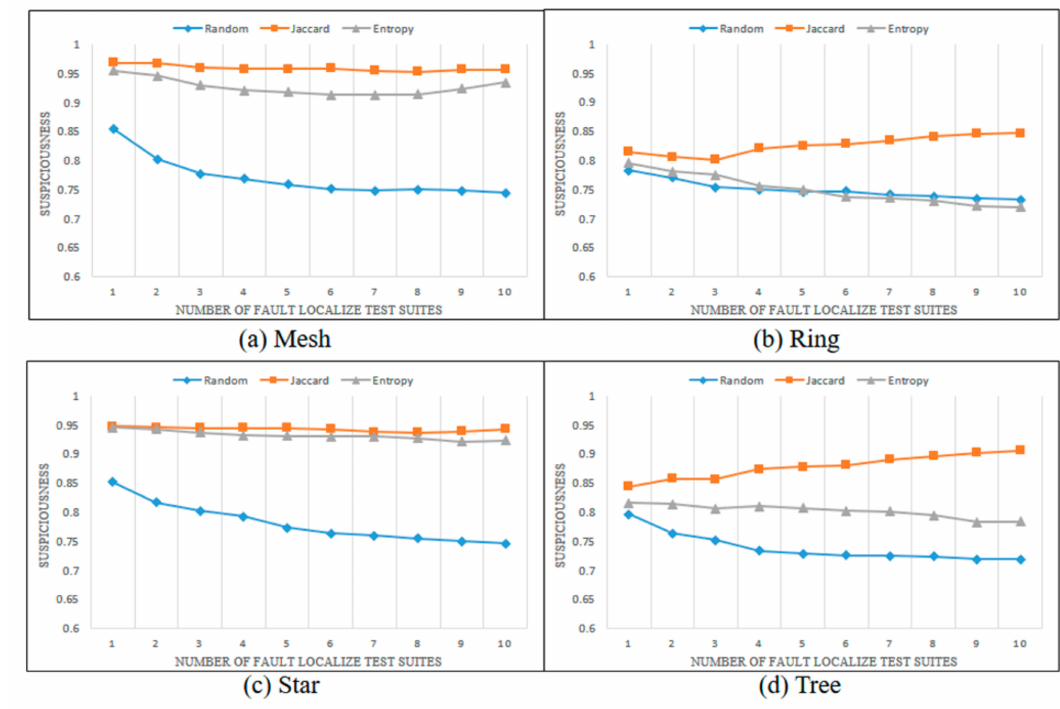
Figure 8. Average suspiciousness of faulty statements (resistant